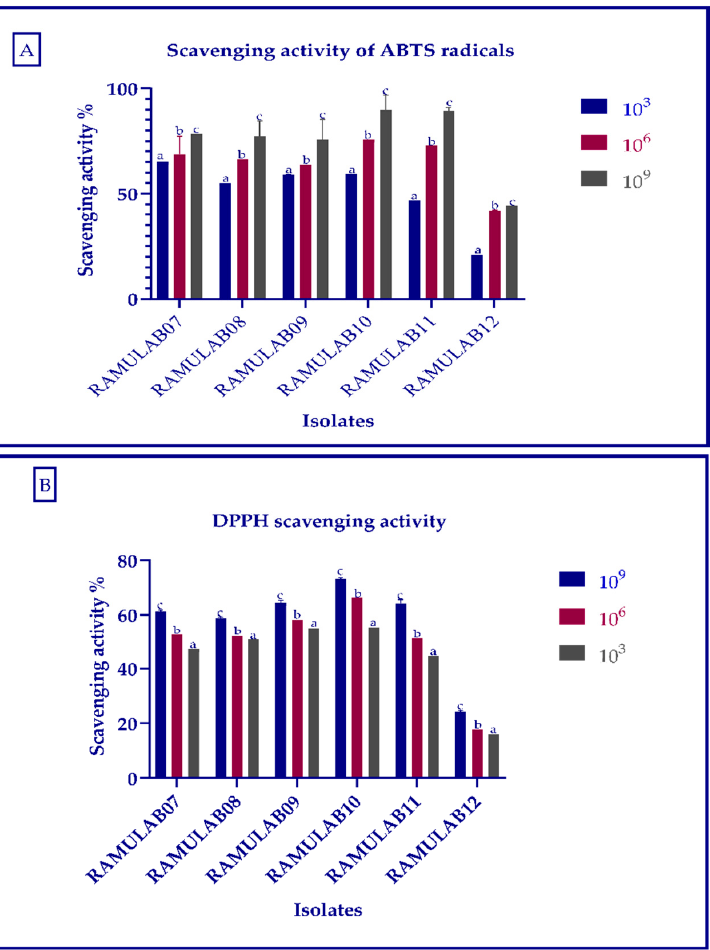
Figure 6. The ( A ) scavenging activity of ABTS radicals and ( B ) DPPH free radical scavenging activity of the isolates. Data are expressed as the mean ± SD. Means in scavenging activity of different CFU/mL with distinct superscripts (a–c) are significantly different ( p ≤ 0.05), as separated by Duncan multiple range test.